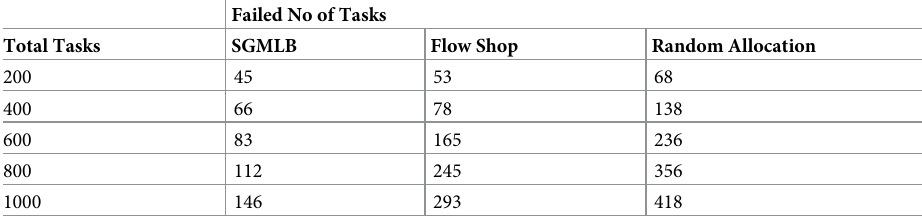
Table 2. Number of tasks failed against total tasks submitted.